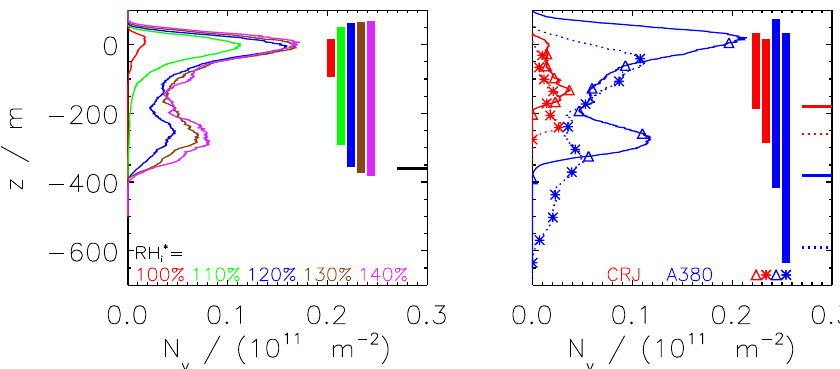
Figure 2. Vertical profiles of contrail ice crystal number after t = 5–6min (well after vortex break-up) are shown. The horizontal bars indicate the value of z desc . The rectangles illustrate the vertical extent of the contrail and their heights are equal to the corresponding contrail depths H . Left panel: variation of relative humidity (see legend) for a B777-type aircraft and N BV = 0 . 0115s − 1 . Right panel: variation of aircraft type (see legend) and stability (solid with triangles: N BV = 0 . 0115s − 1 , dotted with stars: N BV = 0 . 005s − 1 ) for RH i = 140%. In all cases T = 217K. The cruise altitude of the contrail generating aircraft is at z = 0.